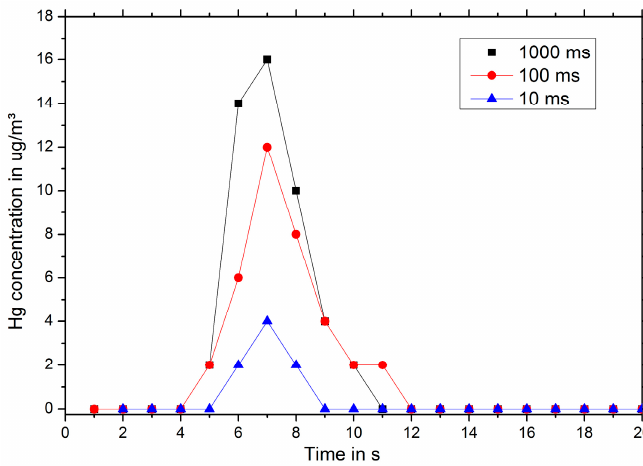
Figure 3. Measured mercury vapor concentration in the exhaust gas for a sensor being exposed to 1.5 mg/m 3 Hg for 30 min and then heated at t = 0 s to 800 °C for 1 s, 100 ms and 10 ms.